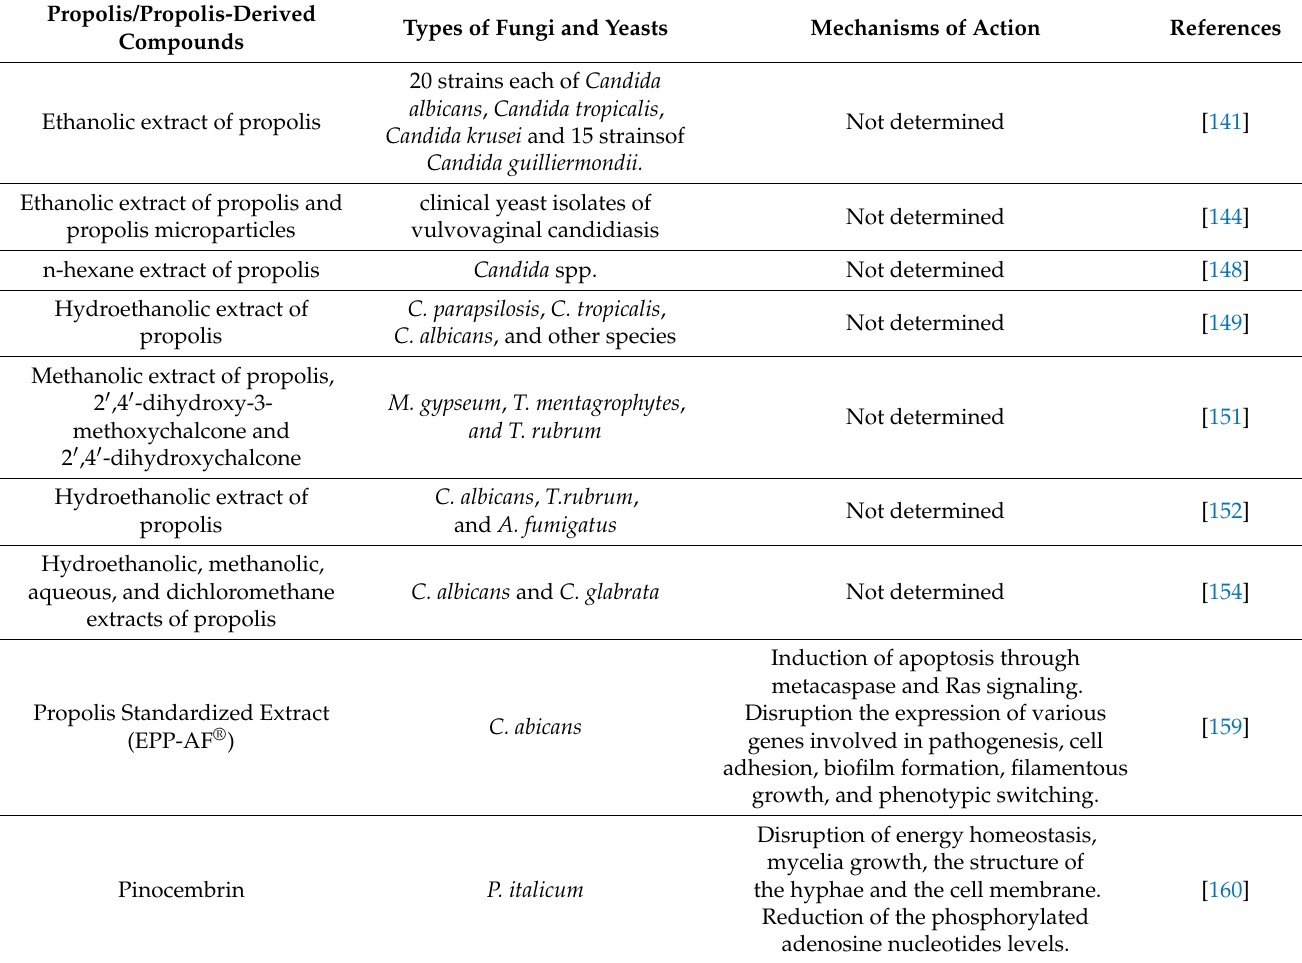
Table 4. Antifungal properties of